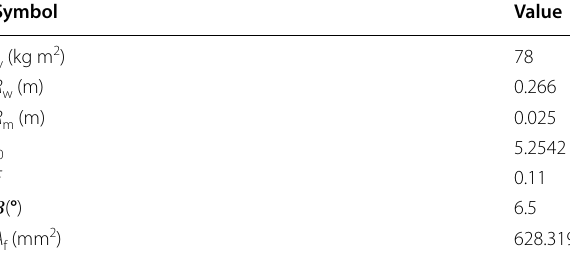
Table 1 Main parameters of the